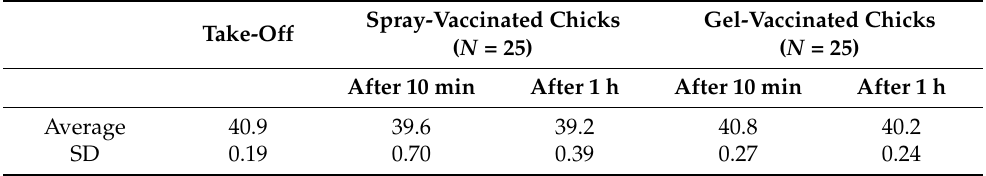
Table 2. Average body temperatures (°C) and standard deviations measured in the spray and gel- vaccinated groups.